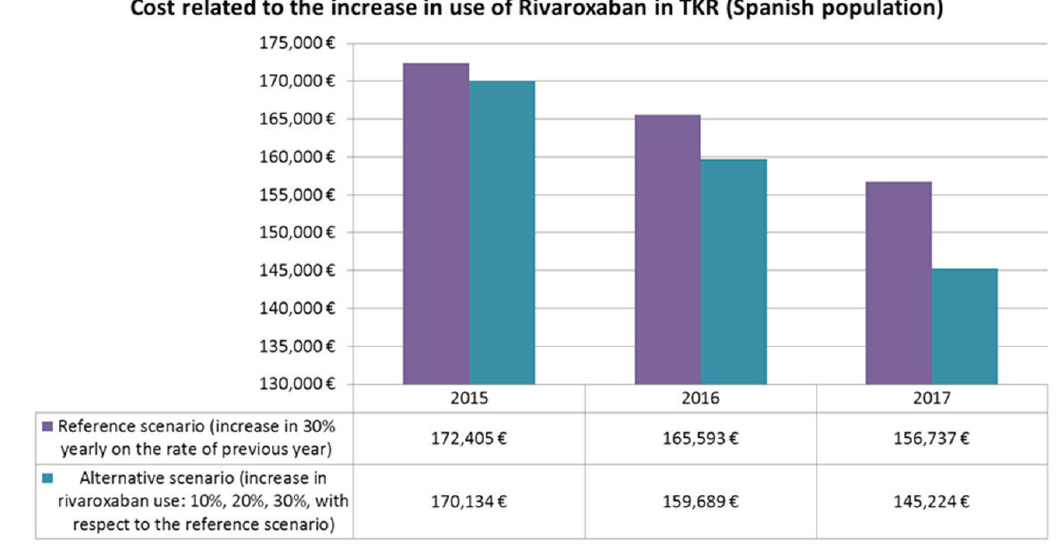
Figure 4. TKR Cohort Costs 2015-2017, Multinational Population; TKR Cohort Total Costs 2015-2017 in